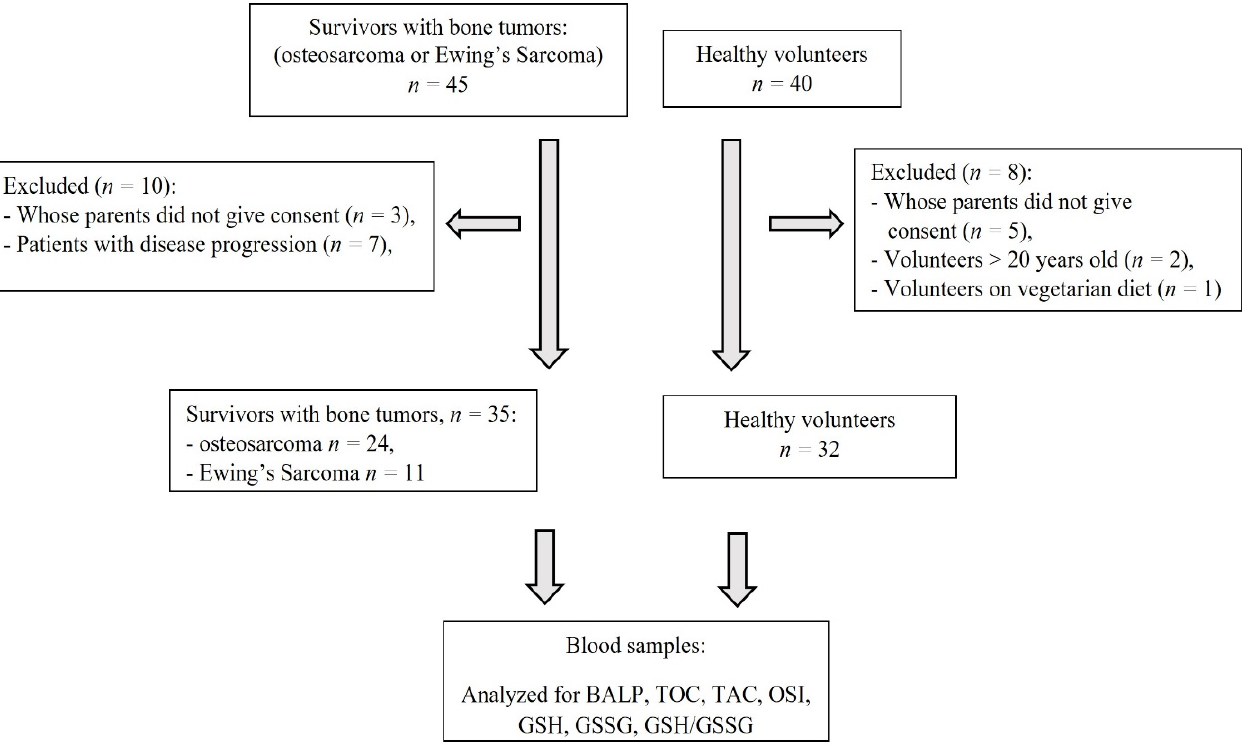
Figure 1. Flowchart of the study. GSH—reduced glutathione, GSSG—oxidized glutathione, TOC—total oxidant capacity, TAC—total antioxidant capacity, OSI—oxidative stress index (TOC/TAC), BALP—bone alkaline phosphatase.